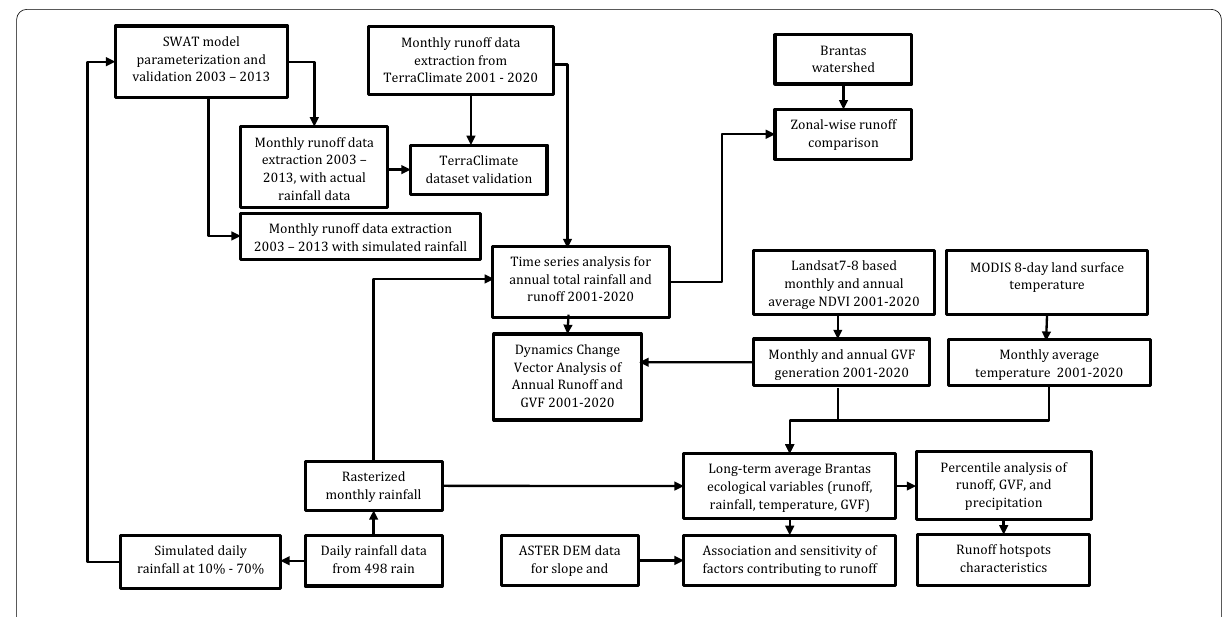
Fig. 2 Schematic diagram of the study’s methodological